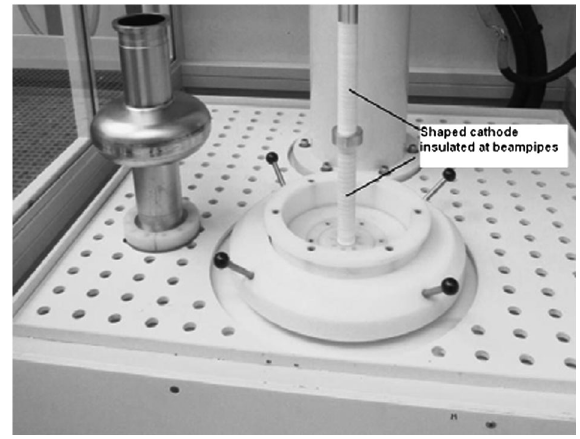
FIG. 14. Single-cell C1-21 Tesla-shape cavity and cathode used for the first VEP